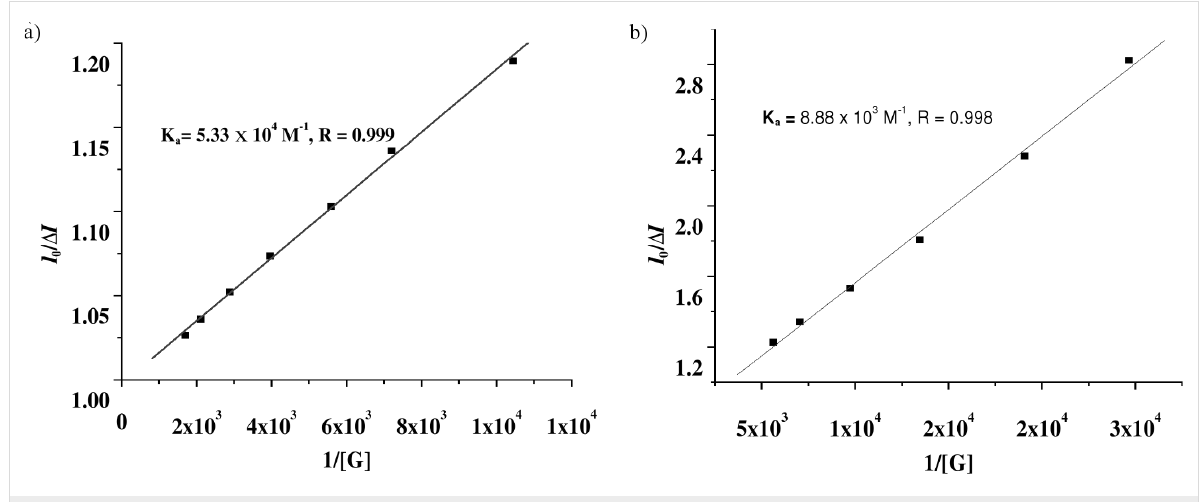
Figure 8: a) Binding constant curve for 1 with Cu 2+ ion; b) binding constant curve for 2 with Cu 2+ ion.